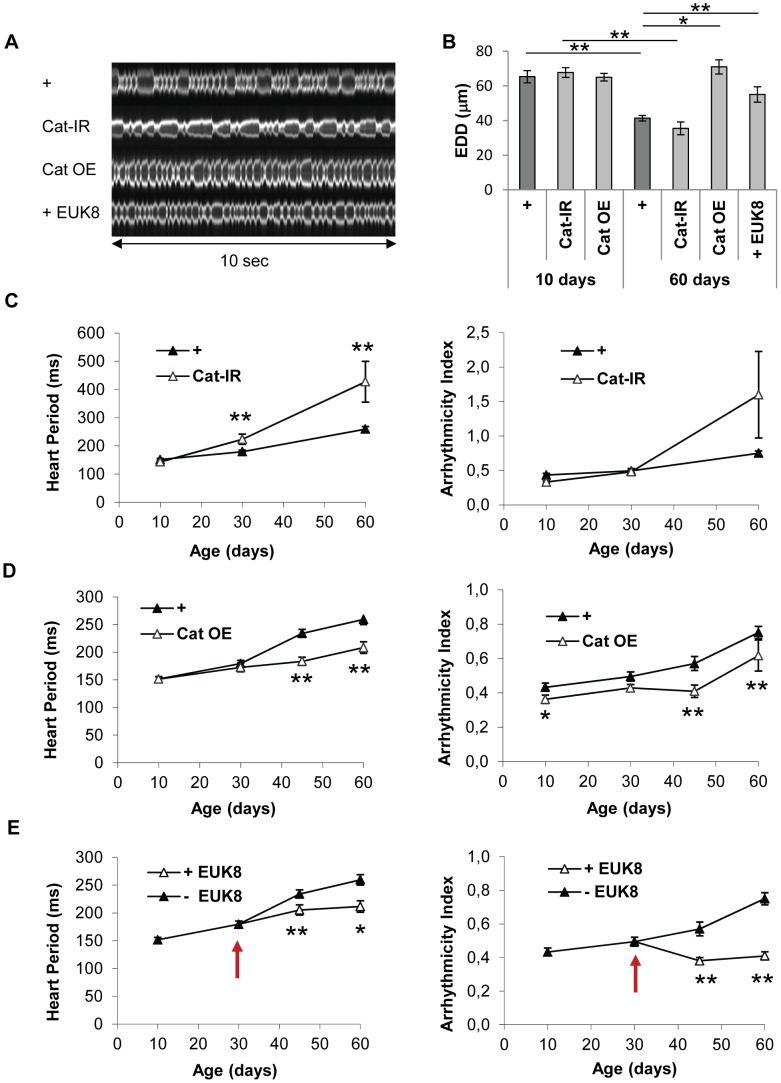
Catalase overexpression and treatment of wild-type flies with a catalase/SOD mimetic improve heart performance.Cardiac imaging was performed on w/Y;UAS-mitoGFP/+; Hand-GS/+ (+), w/Y;UAS-mitoGFP/+; Hand-GS/UAS-Catalase-IR (Cat-IR), w/Y;UAS-mitoGFP/UAS-Catalase; Hand-GS/+ (Cat OE) male flies. w/Y;UAS-mitoGFP/+; Hand-GS/+ male flies were treated with EUK-8 (0.2 mM) from the age of 30 days (+ EUK-8, red arrow shows the start of the treatment). All flies were treated with RU 486 (100 µg/ml of food) during adulthood. (A) Representative 10 second M-Modes of 60-day-old flies. (B) End Diastolic Diameter (EDD, µm) in 10-day-old and 60-day-old flies. Significant differences are indicated: * p<5.10−2, ** p<5.10−3. (C,D,E) Heart Period (ms) and Arrhythmicity Index. Significant differences with control (+) flies of the same age are indicated: * p<5.10−2, ** p<5.10−3. All values are means (±SEM). +/10 days: n = 26; +/30 days: n = 34; +/45 days: n = 34; +/60 days: n = 32; Cat-IR/10 days: n = 10; Cat-IR/30 days: n = 10; Cat-IR/60 days: n = 10; Cat OE/10 days: n = 19; Cat OE/30 days: n = 9; Cat OE/45 days: n = 19; Cat OE/60 days: n = 17; +EUK-8/45 days: n = 19; +EUK-8/60 days: n = 7.